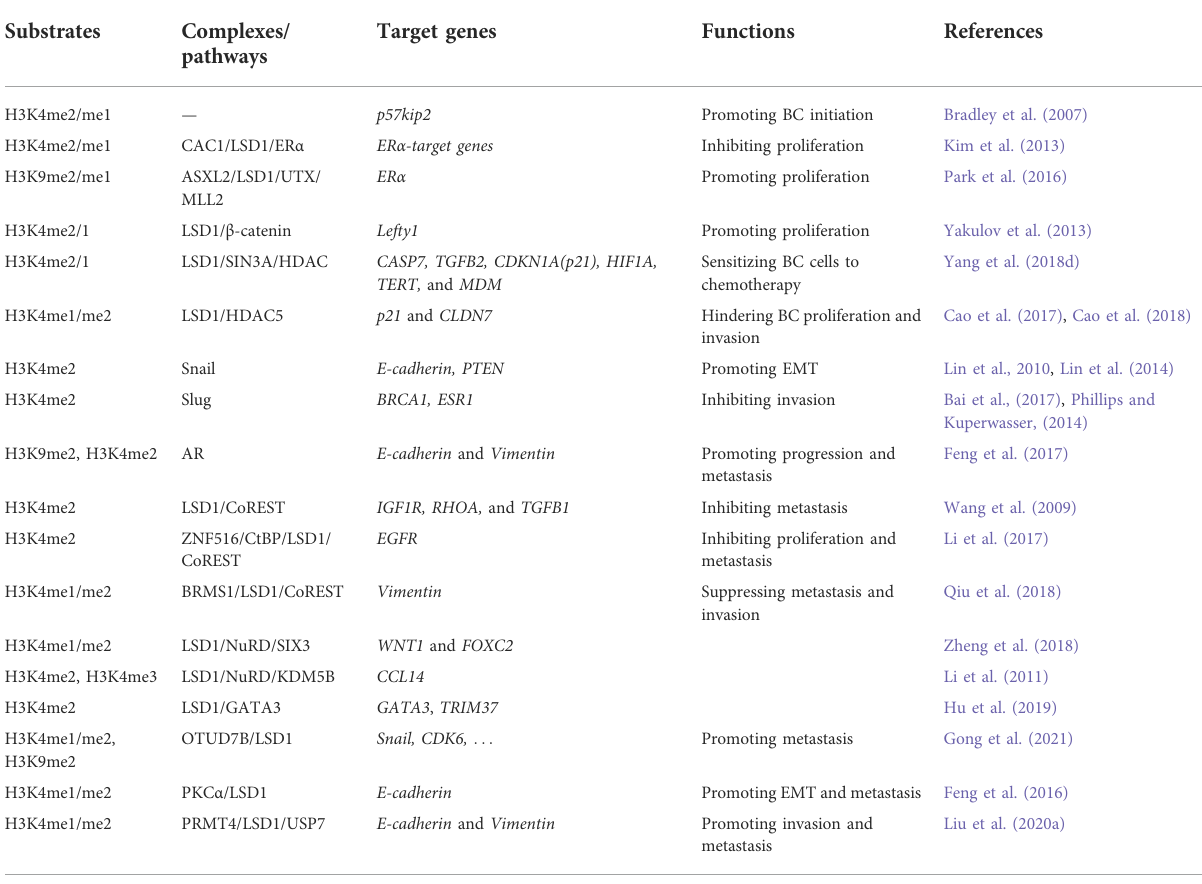
TABLE 1 Roles of LSD1 in BC progression.